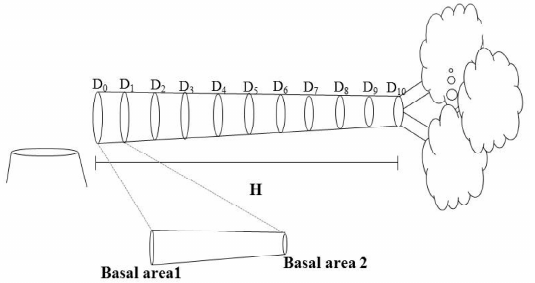
Figure A2. Illustration of the tree cubing method by HOHENALDL (10 sections) and sections by Smalian.